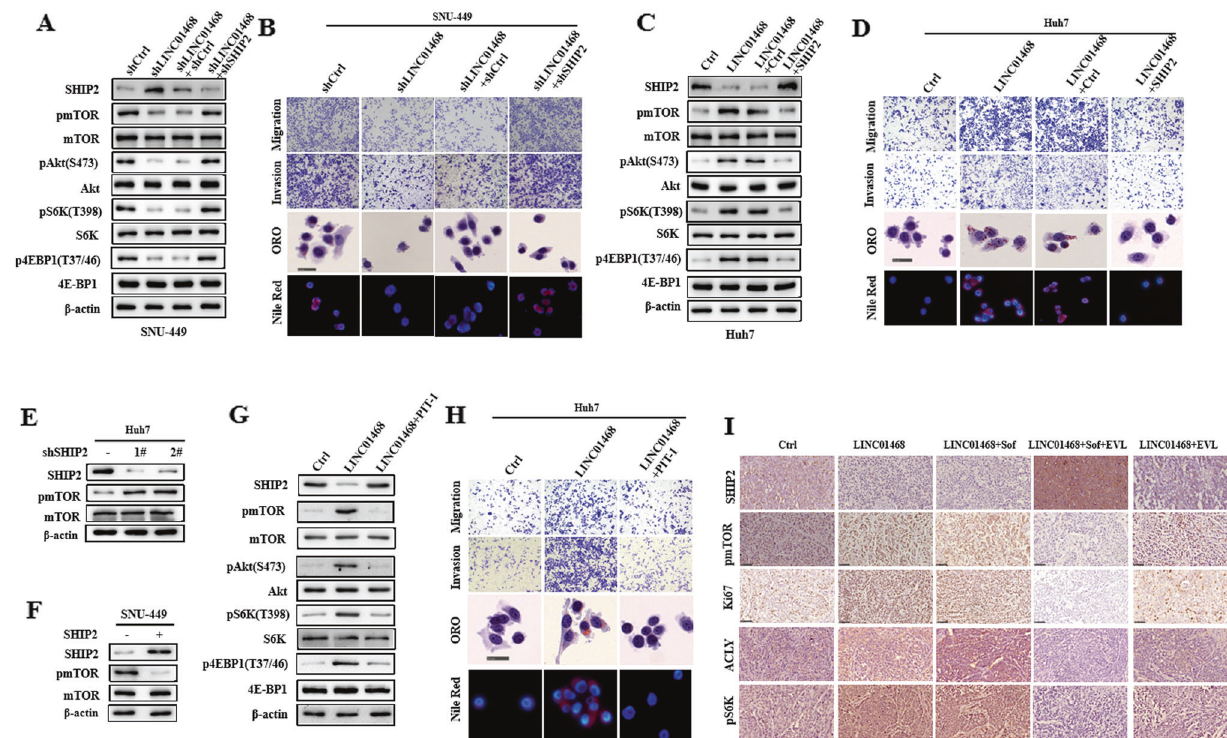
Fig. 7 Enforced expression of SHIP2 rescues the LINC01468 metabolic phenotypes. A Western blotting analysis of the SHIP2/Akt/mTOR pathway protein in SNU-449 cells cotransfected with or without shLINC01468, together with shSHIP2 or empty vector. B Migration, invasion, ORO staining, and Nile Red staining were performed in SNU-449 cells as described in A . C Western blotting analysis of the SHIP2/Akt/mTOR pathway protein in Huh7 cells cotransfected with LINC01468 or the control, together with SHIP2 or empty vector. D The migration, invasion, ORO staining, and Nile red staining were performed in Huh7 cells as described in B . E , F Immunoblot detection of pmTOR level in SHIP2 E silencing in Huh7 cells or F overexpression in SNU-449 cells. G Immunoblotting of the indicated protein lysates from Huh7 cells expressing Ctrl or LINC01468 treated with or without the PIP3 inhibitor PIT-1. H Migration, invasion, ORO staining, and Nile Red staining were performed in SNU-449 cells as described in G . I Expression of LINC01468/SHIP2/mTOR cascade and Ki67 in HCC xenograft tissues. The expression of SHIP2, pmTOR, p-4E-BP1, and Ki67 was examined by IHC. Scale bars, 50 μ m. Sof sorafenib, EVL everolimus (the mTOR